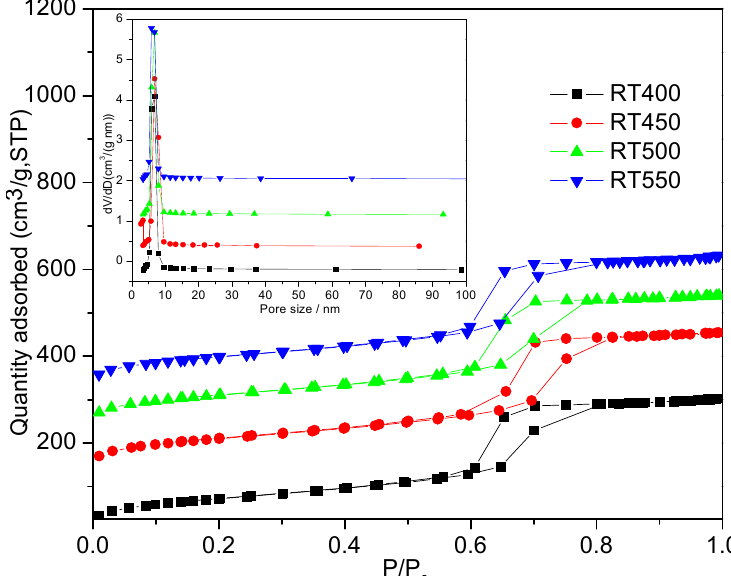
Figure 5. N 2 adsorption-desorption isotherms and pore diameter distributions of the prepared RTx catalysts. (x = 400, 450, 500, and 550).